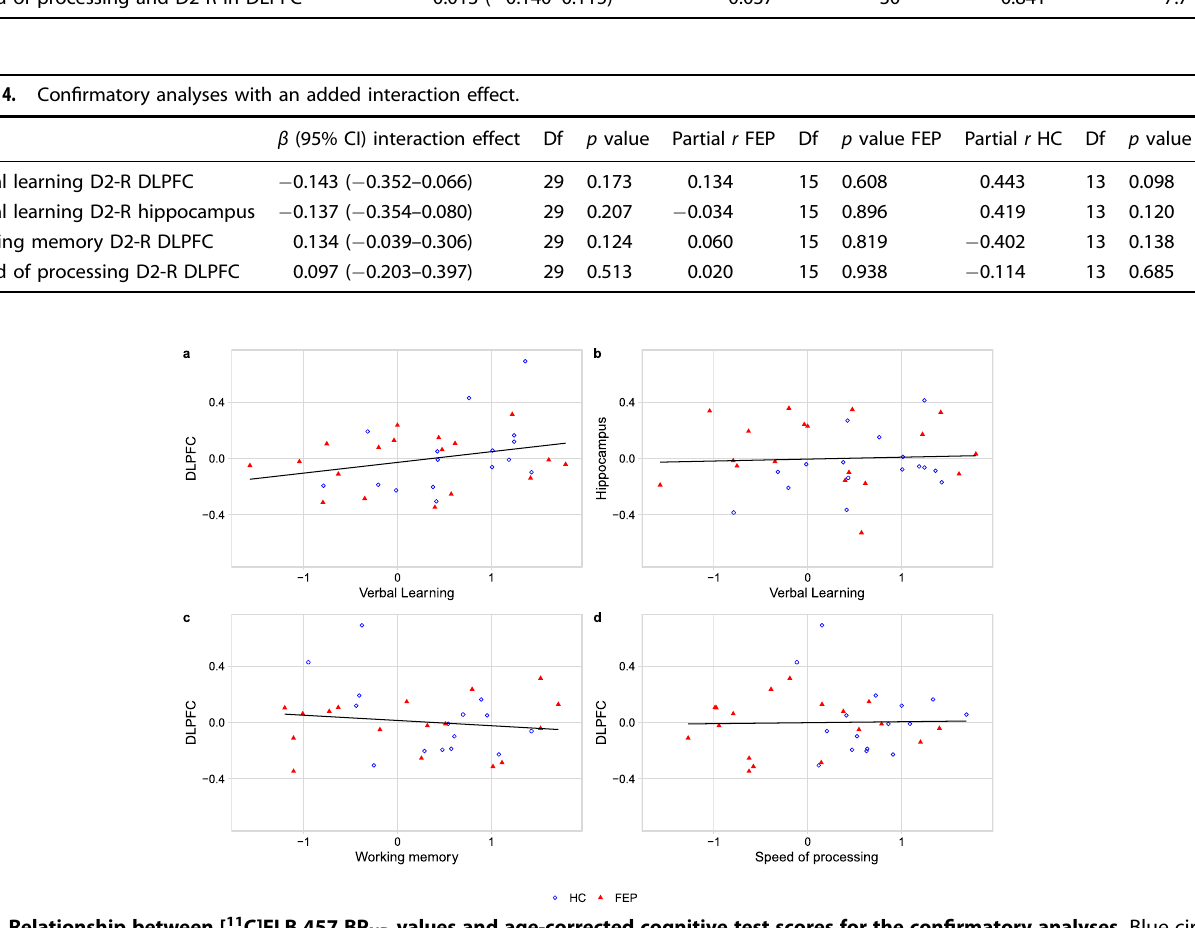
Fig. 1 Relationship between [ 11 C]FLB 457 BP ND values and age-corrected cognitive test scores for the con fi rmatory analyses. Blue circles indicate HC, red triangles indicate FEP. The gray area indicates a 95% con fi dence interval for the regression line. a BP ND in DLPFC and verbal learning, b BP ND in the hippocampus and verbal learning, c BP ND in DLPFC and working memory, d BP ND in DLPFC and speed of